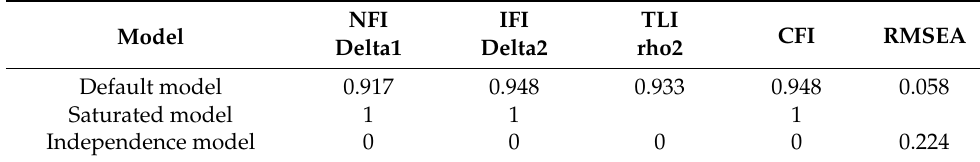
Figure 2. Path model: standardized estimates. Table 5. Baseline comparisons and